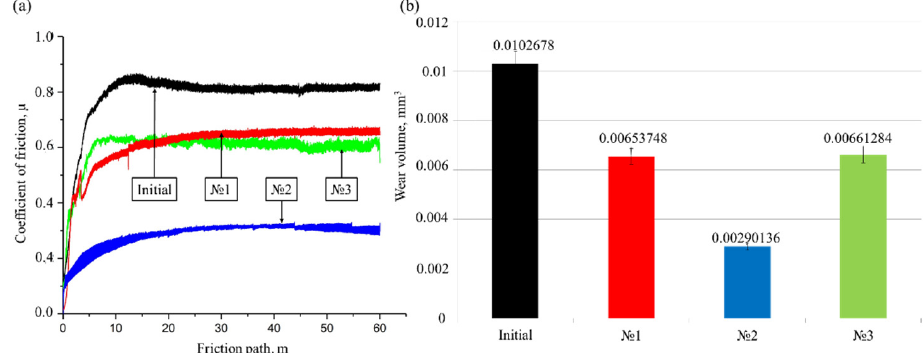
Figure 6. Distribution graph of ( a ) coefficient of sliding friction and ( b ) wear volume of 40 Kh steel.